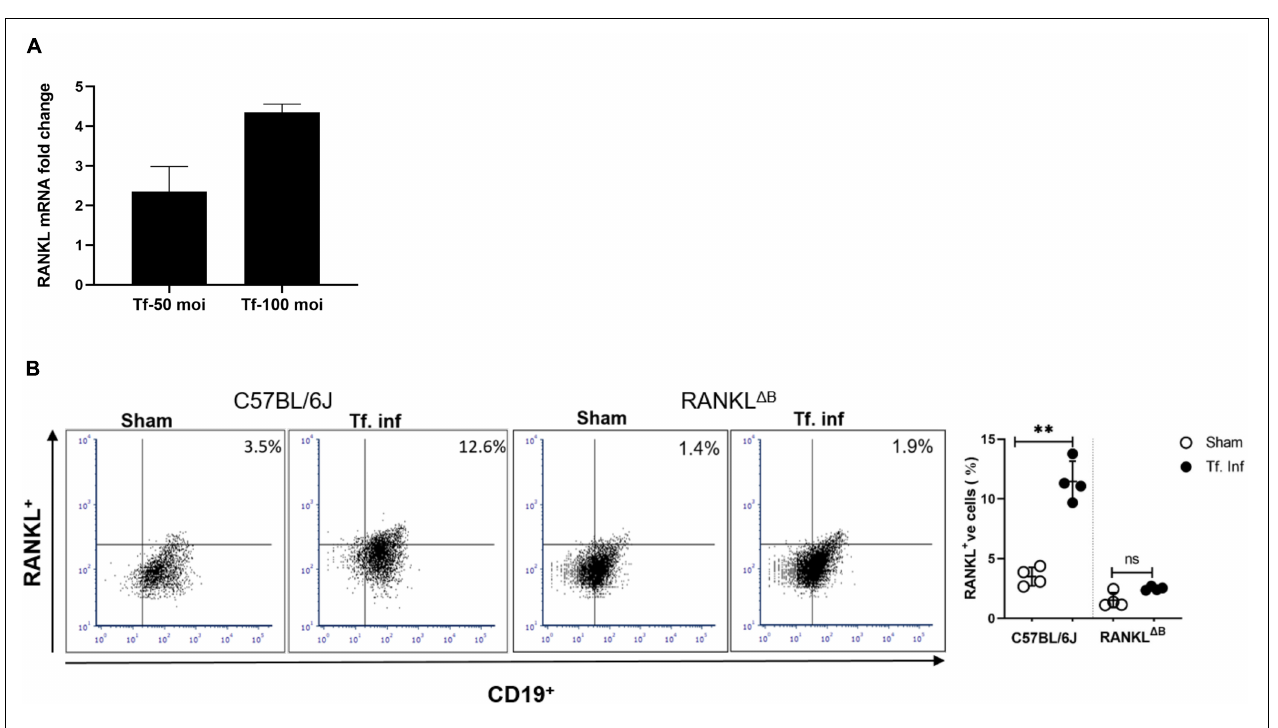
FIGURE 2 | T. forsythia infection induces RANKL expression on B cells. Expression levels of RANKL in mouse B cells. T. forsythia infected mouse spleen B cells were purified and re-stimulated with T. forsythia at an MOI of 50 and 100 for 48 h. After re-stimulation, RANKL mRNA and B cell surface expression levels were determined by RT-qPCR (A) and flow cytometry (B) , respectively. (A) Data show fold-increase in RANKL expression in B cells from T. forsythia -infected mice versus sham-infected mice. (B) Representative flow cytometry plots of draining cLN B cells showing dual RANKL/CD19 positive cells in the upper right quadrant. Bar graphs on the right show mean ( ± s.d) percentages of RANKL producing cells in one of two experiments with four mice in each group. Data are presented as means ± s.d. ( n = 4 animals/group). ∗∗ P < 0.01.